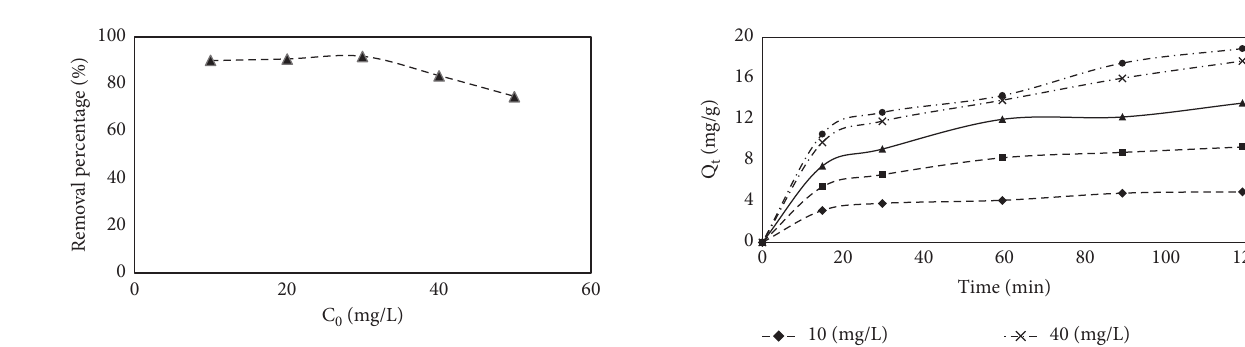
Figure 7: Effect of Cr(VI) concentration on the adsorption rate from aqueous solution using WM adsorbent at T � 298 (K), pH � 2, time � 120min, and adsorbent dose W � 2g/L.